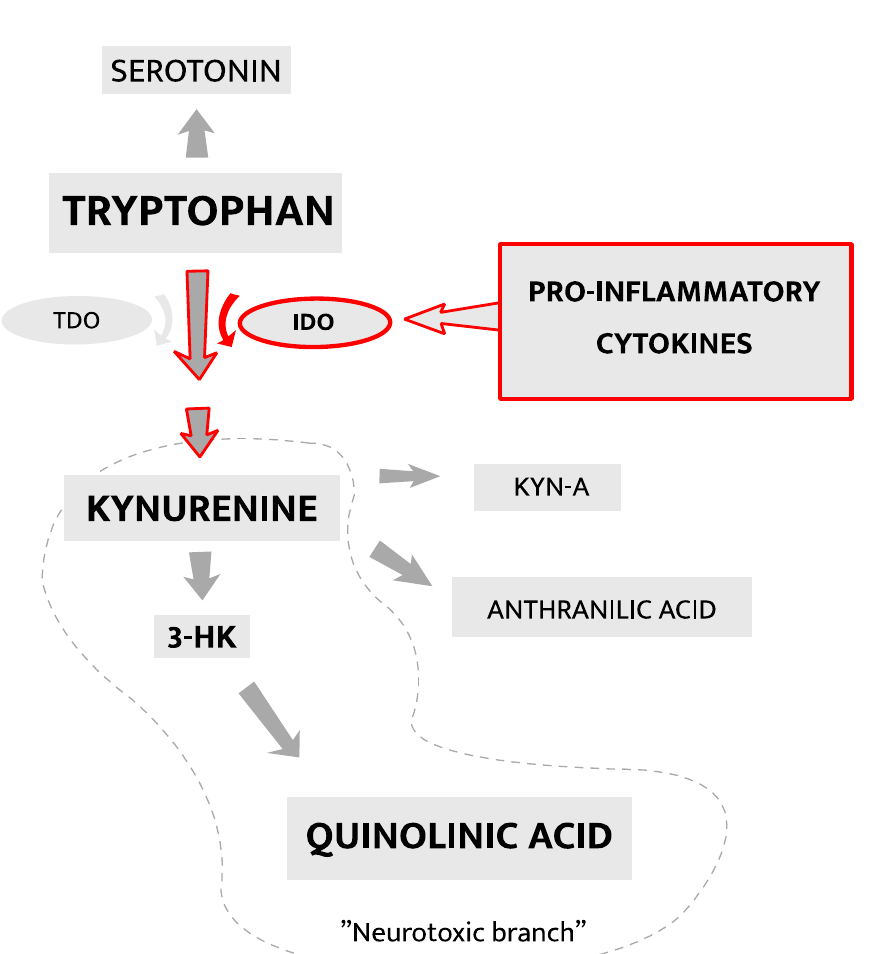
Figure 4. Metabolization of the essential amino acid tryptophan is shown in a simplified schematic with focus on the metabolites discussed in this review. Marked in red is the activation of IDO by pro-inflammatory cytokines, triggering the formation of kynurenine from tryptophan. This is the first and rate-limiting step of the kynurenine pathway. Abbreviations: tryptophan 2,3-dioxygenase (TDO), indoleamine 2,3-dioxygenase (IDO), 3-hydroxykynurenine (3-HK), kynurenic Acid